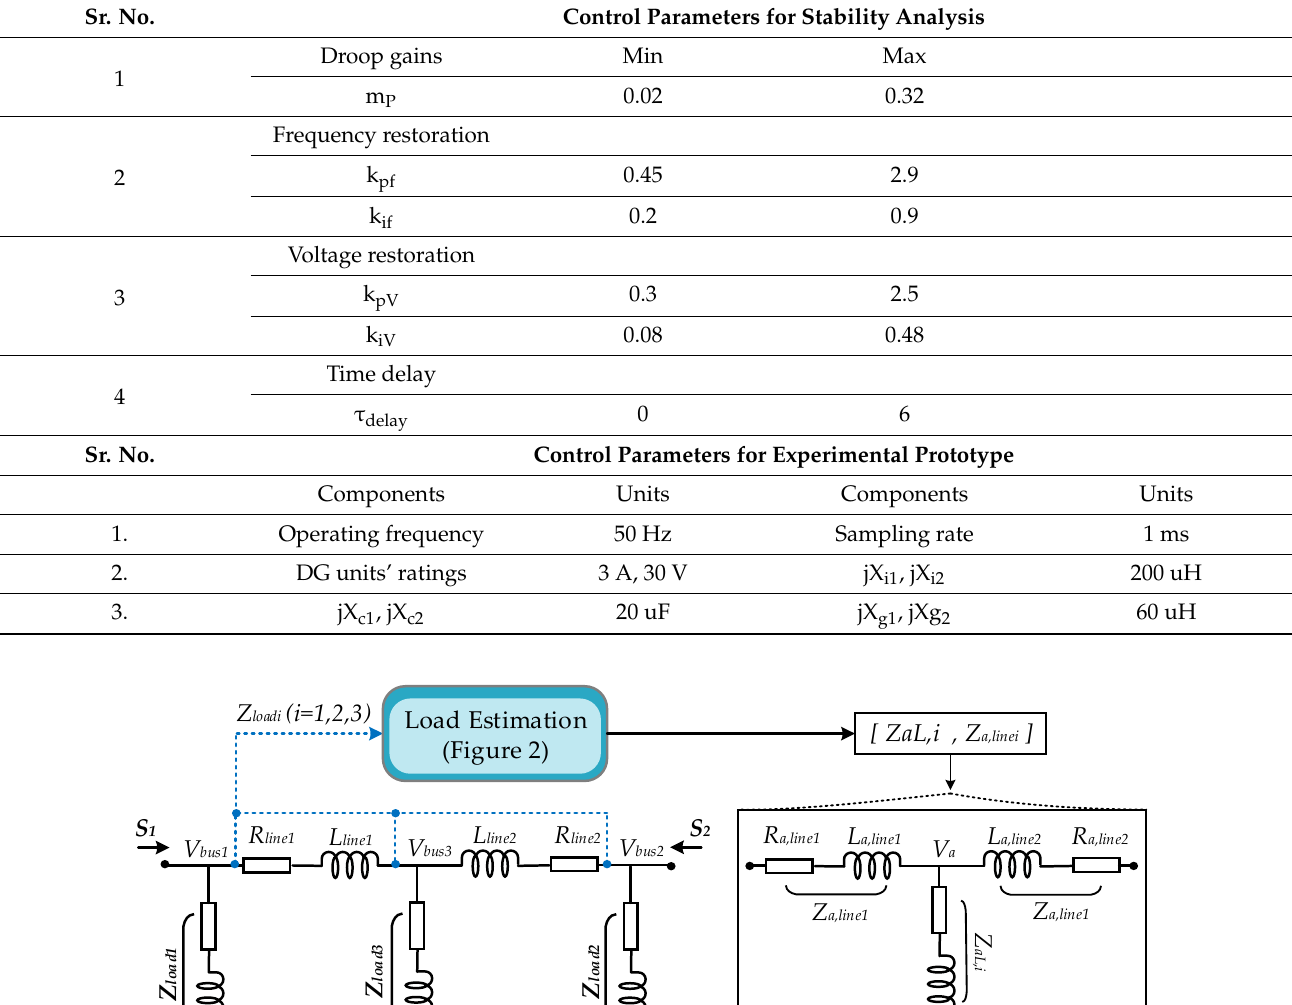
Table 2. System parameters for stability analysis and experimental prototype.